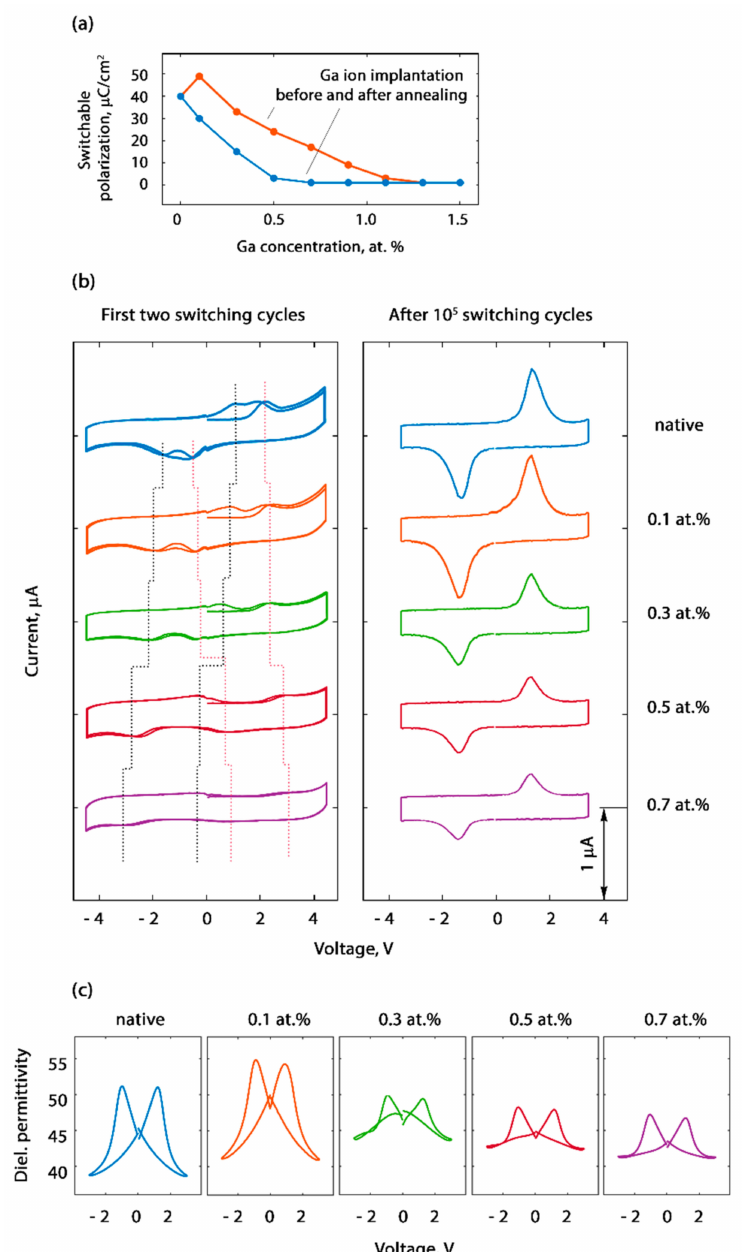
Figure 2. Electrophysical properties of homogeneously doped HZO capacitors: ( a ) Dependences of the switchable polarization on the Ga concentration for ion implantation performed before or after crystallization; switchable polarization obtained after 10 5 switching cycles. ( b ) Switching I–V curves measured during the first two switching cycles and after 10 5 switching cycles for selected Ga concentrations. Dotted lines indicate the positions of the current peaks. ( c ) C–V curves measured after 10 5 switching